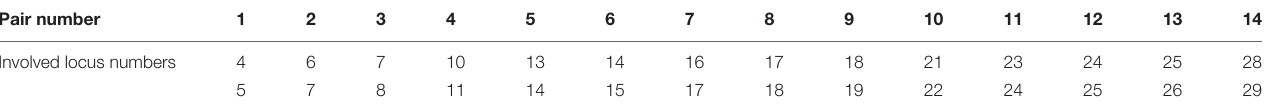
TABLE 1 | Set of 14 inseparable loci pairs corresponding to loci distant of less than 12.5 cM.